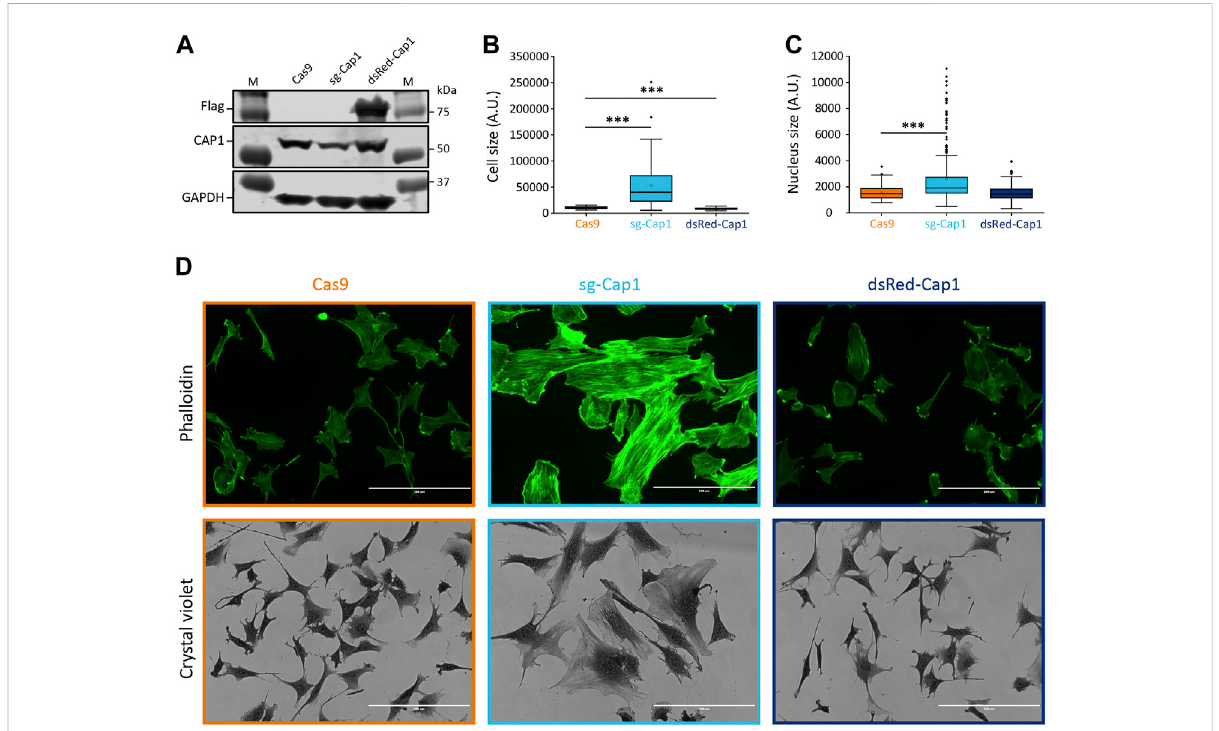
FIGURE 2 Knockoutof Cap1 resultsinincreasedsizeofcellsandnucleiandaccumulated F-actin fi bersinC2C12cells. (A) Validationofpartialknockoutby CRISPR-Cas9(sg-Cap1)andoverexpression(dsRed-Cap1)inC2C12poolsbyimmunoblot,comparedtocontrolcellsinfectedwithCas9only(Cas9). The sg-Cap1 cells show reduced expression of endogenous CAP1 while ectopically expressed dsRed-Cap1 results in an additional band corresponding to tagged CAP1 proteins ( n = 3). (B) Quanti fi cation of the cell area covered, based on crystal violet staining ( n = 50 cells). (C) Quanti fi cation of the nucleus size ( n = 100 nucleus). (D) Micrographs, the upper panel shows fl uorescence images of phalloidin-stained cells. The lower panel shows bright- fi eld images (×20) of crystal violet stained cells. Data presented here are from two-week post transduction. The cell and nucleus size quanti fi cations are presented as box plot, showing mean (cross), median (line), 25th and 75th percentile (box). The whiskers extend to the most extreme data points not considered outliers, and the outliers are represented as dots; *** p < 0.001 (Student ’ s t -test). Scale bar, 200 μ